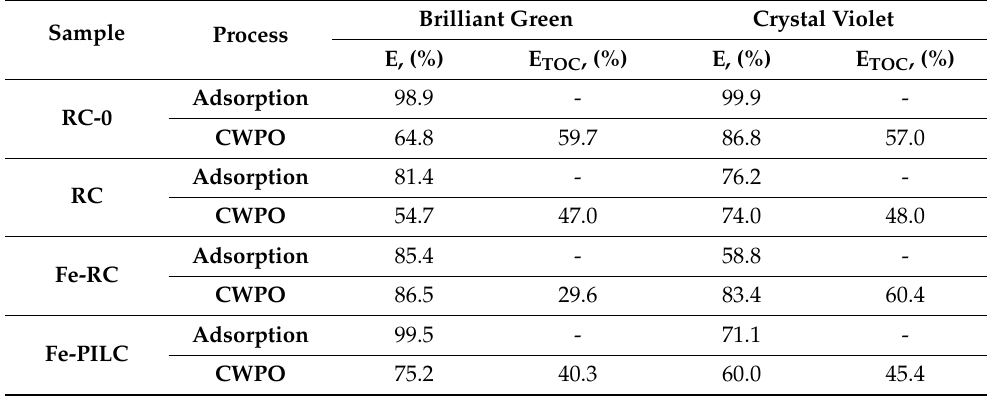
Table 3. Efficiency values for CWPO and adsorption on selected samples (250 mg/L dye